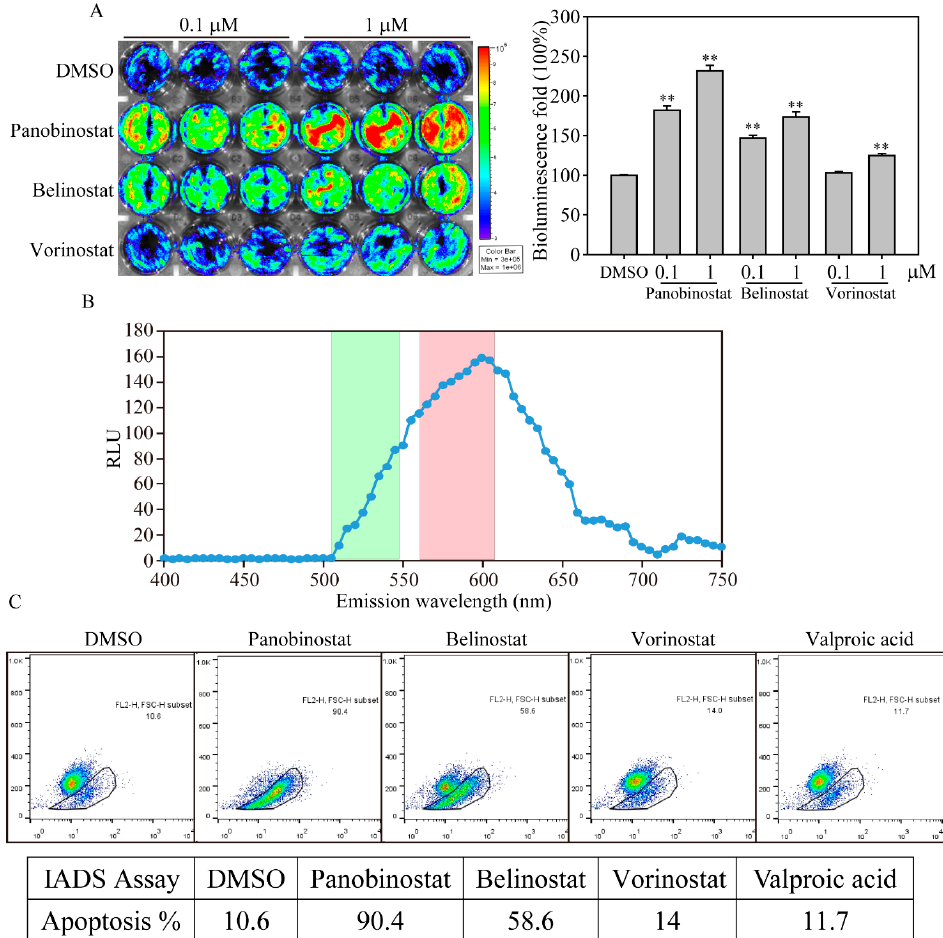
Figure 2. HDACi induced K562 cell apoptosis in bioluminescence-based live cell measurement. ( A ) The IVIS image of HDACi-induced cell apoptosis in NIADS stably expressed K562 (NIADS-K562) cells. The cells received HDACis or DMSO at various concentrations (0.1 and 1 μ M) for 12 h and measured luciferase activity (present by photos influx). The cells in a 24-well plate were exposed to luciferin at a concentration of 1.5 μ g/mL and calculated in an IVIS 200 Spectrum image system. The yellow and red colors indicate high photons of bioluminescence activity, whereas the green and blue colors indicate low photons of bioluminescence activity. The intense luciferase activity indicates apoptotic signals from NIADS. The bar figure illustrates the 100% mean and standard deviation of the photons compares to DMSO addition. Data were analyzed with Student’s t-test; all p -values were two-sided. p -values less than 0.01 are presented with two asterisks. ( B ) The emission wavelength spectrum of the NIADS protein. NIADS-K562 cells were exposed to luciferin, and the wavelength spectrum was measured every 5 nm from 400 nm to 750 nm. The green bar in the background indicates the fluorescent wavelength that can be detected in the FL1 channel, whereas the red bar indicates the fluorescent wavelength in the FL2 channel of flow cytometry. ( C ) Apoptosis detection in HDACi-treated NIADS-K562 cells. The cells were exposed to 1.5 μ g/mL luciferin, and bioluminescence was measured in the FL2 channel of a flow cytometer. Apoptotic NIADS-K562 cells with bioluminescence were calculated in the whole cell population.